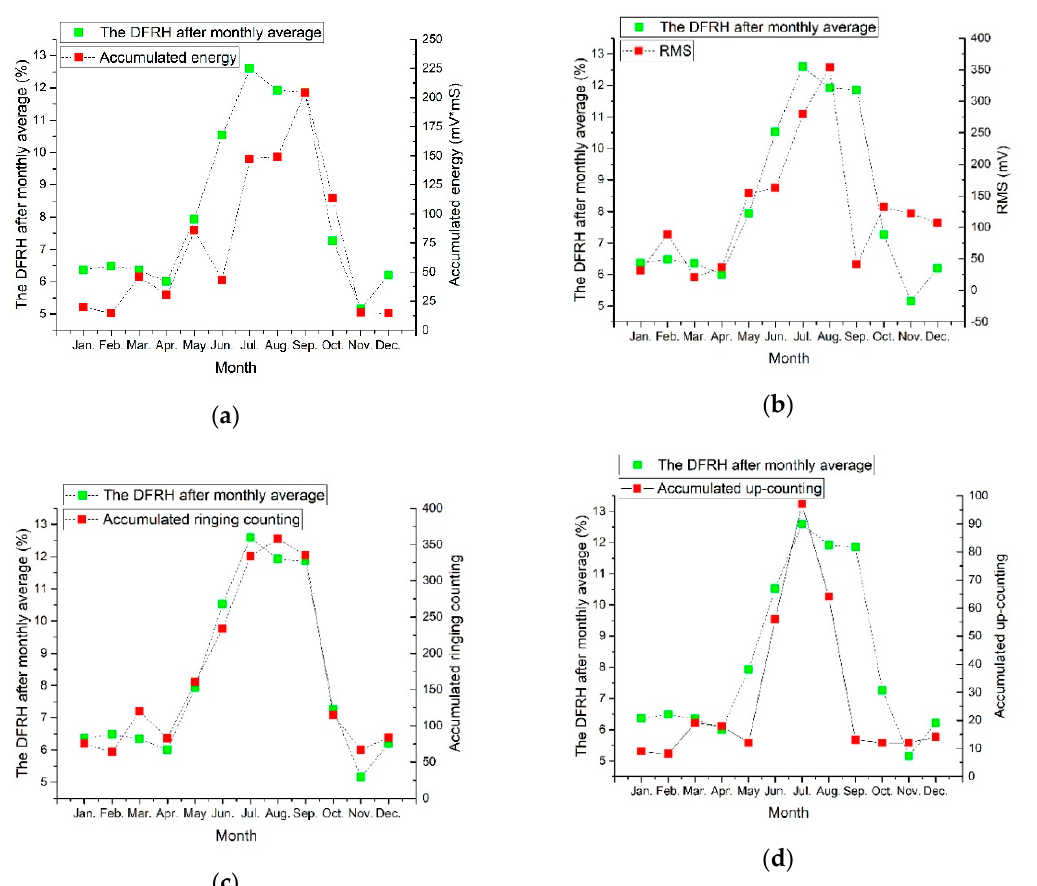
Figure 10. The relationship between acoustic emission parameters and daily fluctuation of relative humidity (DFRH) after monthly average.